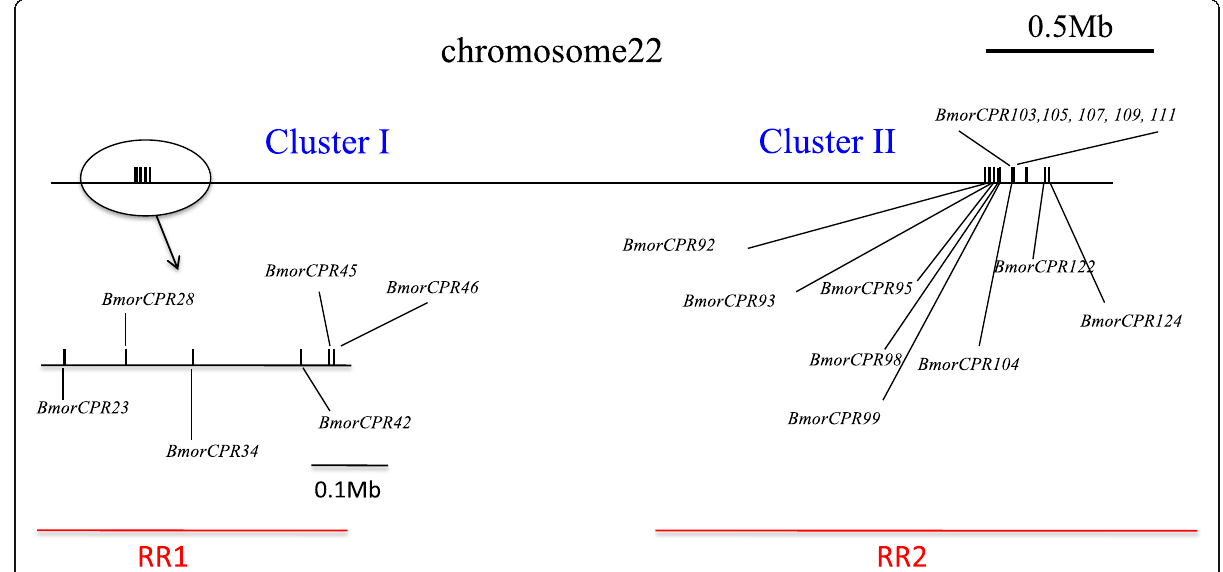
Fig. 2 Schematic representation of CP genes clustering on the Chromosome22. An upper bar indicating 0.5